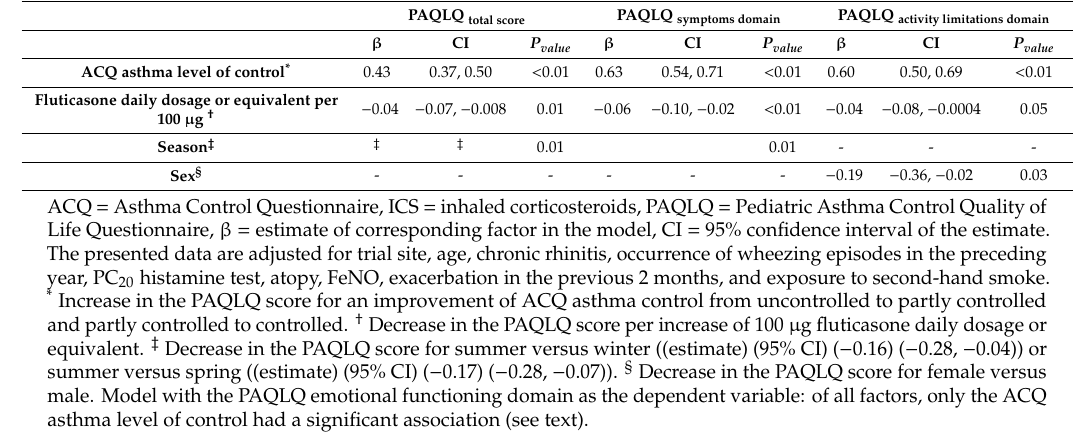
Table 3. Results of the multivariate models with the PAQLQ score as the dependent variable and independent predictors of asthma control (assessed by the ACQ) and other (clinical) parameters (dose of fluticasone or equivalent, age, sex, trial site, season, chronic rhinitis, wheezing episodes in the preceding year, PC 20 histamine test, atopy, FeNO, exacerbations in the previous 2 months, and exposure to second-hand smoke). Only significant results are shown. PAQLQ totalscore PAQLQ symptomsdomain PAQLQ activitylimitationsdomain β CI P value β CI P value β CI P value ACQ asthma level of control * 0.43 0.37, 0.50 < 0.01 0.63